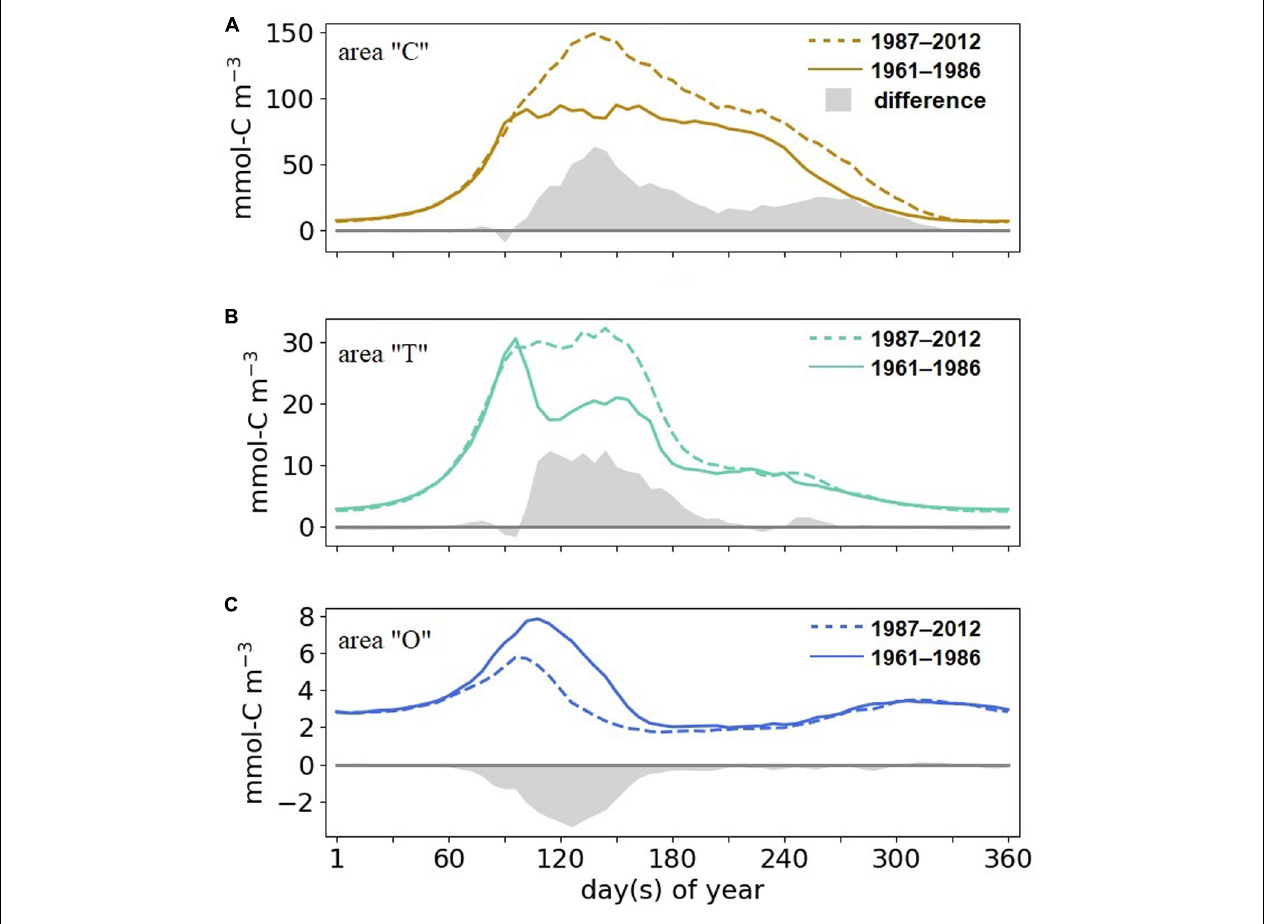
FIGURE 7 | Simulated 6-day mean phytoplankton biomass and changes between 1987–2012 and 1961–1986 (shading) (A) in areas “C,” (B) “T,” (C) and